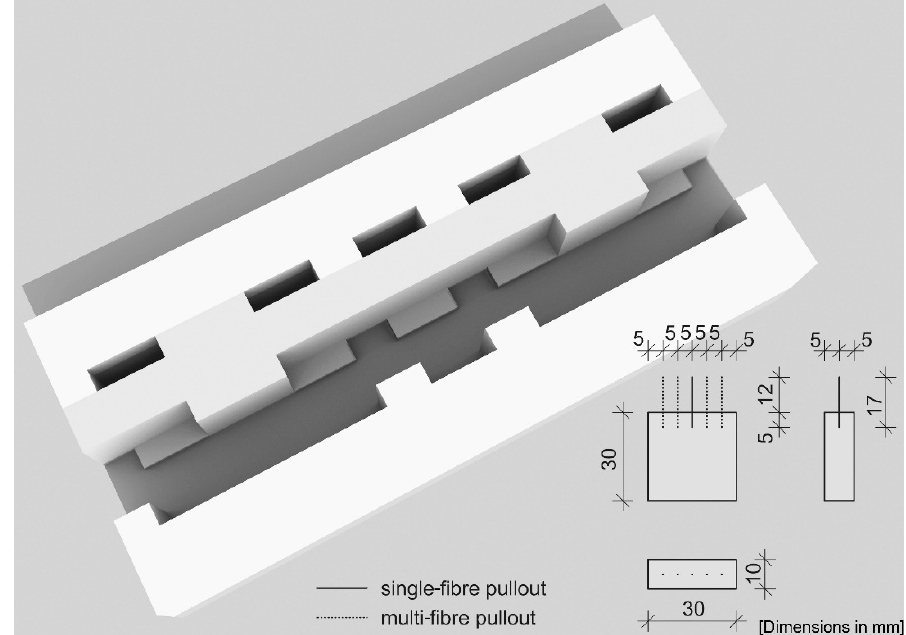
Figure 3. Isometry of the CTS formwork for the production of test samples for single- and multi-fibre pullout tests and the dimensions of the test samples in mm.